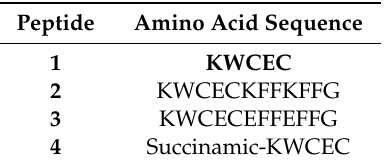
Table 1. Synthetic peptides and amino acid